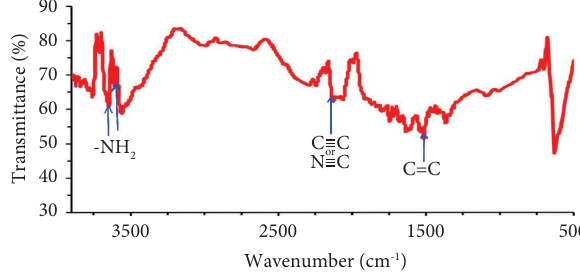
Figure 4: FTIR spectrum of the HP-CQDs.